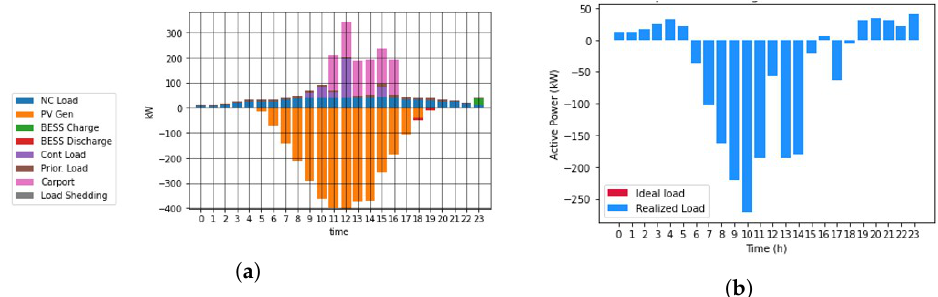
Figure 15. Microgrid’s dispatch to active network with increase load. ( a ) Dispatch of the microgrid. ( b ) Dispatch from the point of view of the active network.